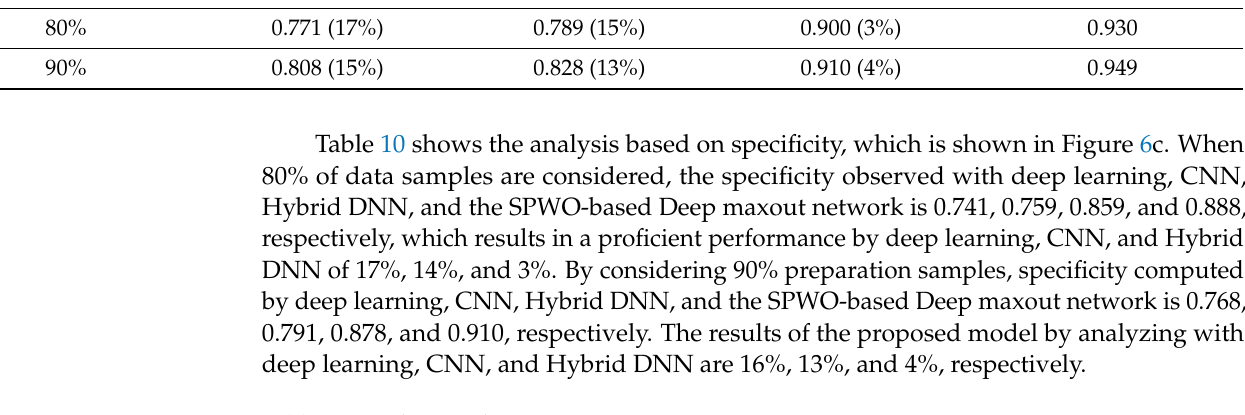
Table 10. Analysis with